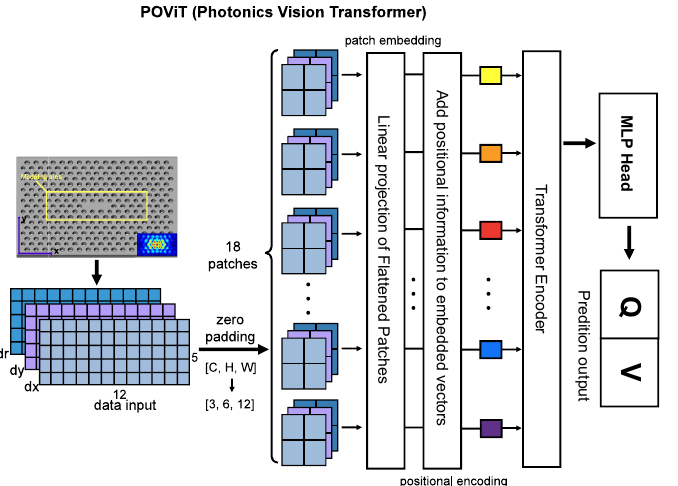
Figure 2. Architecture of the POViT where input tensor shape is N × 3 × 5 × 12 and output tensor shape is N × 2. Input is our PC nanolaser converted into images while output is the predicted Q and V . Also shown are the transformer encoder with attention, positional encoding as well as patch